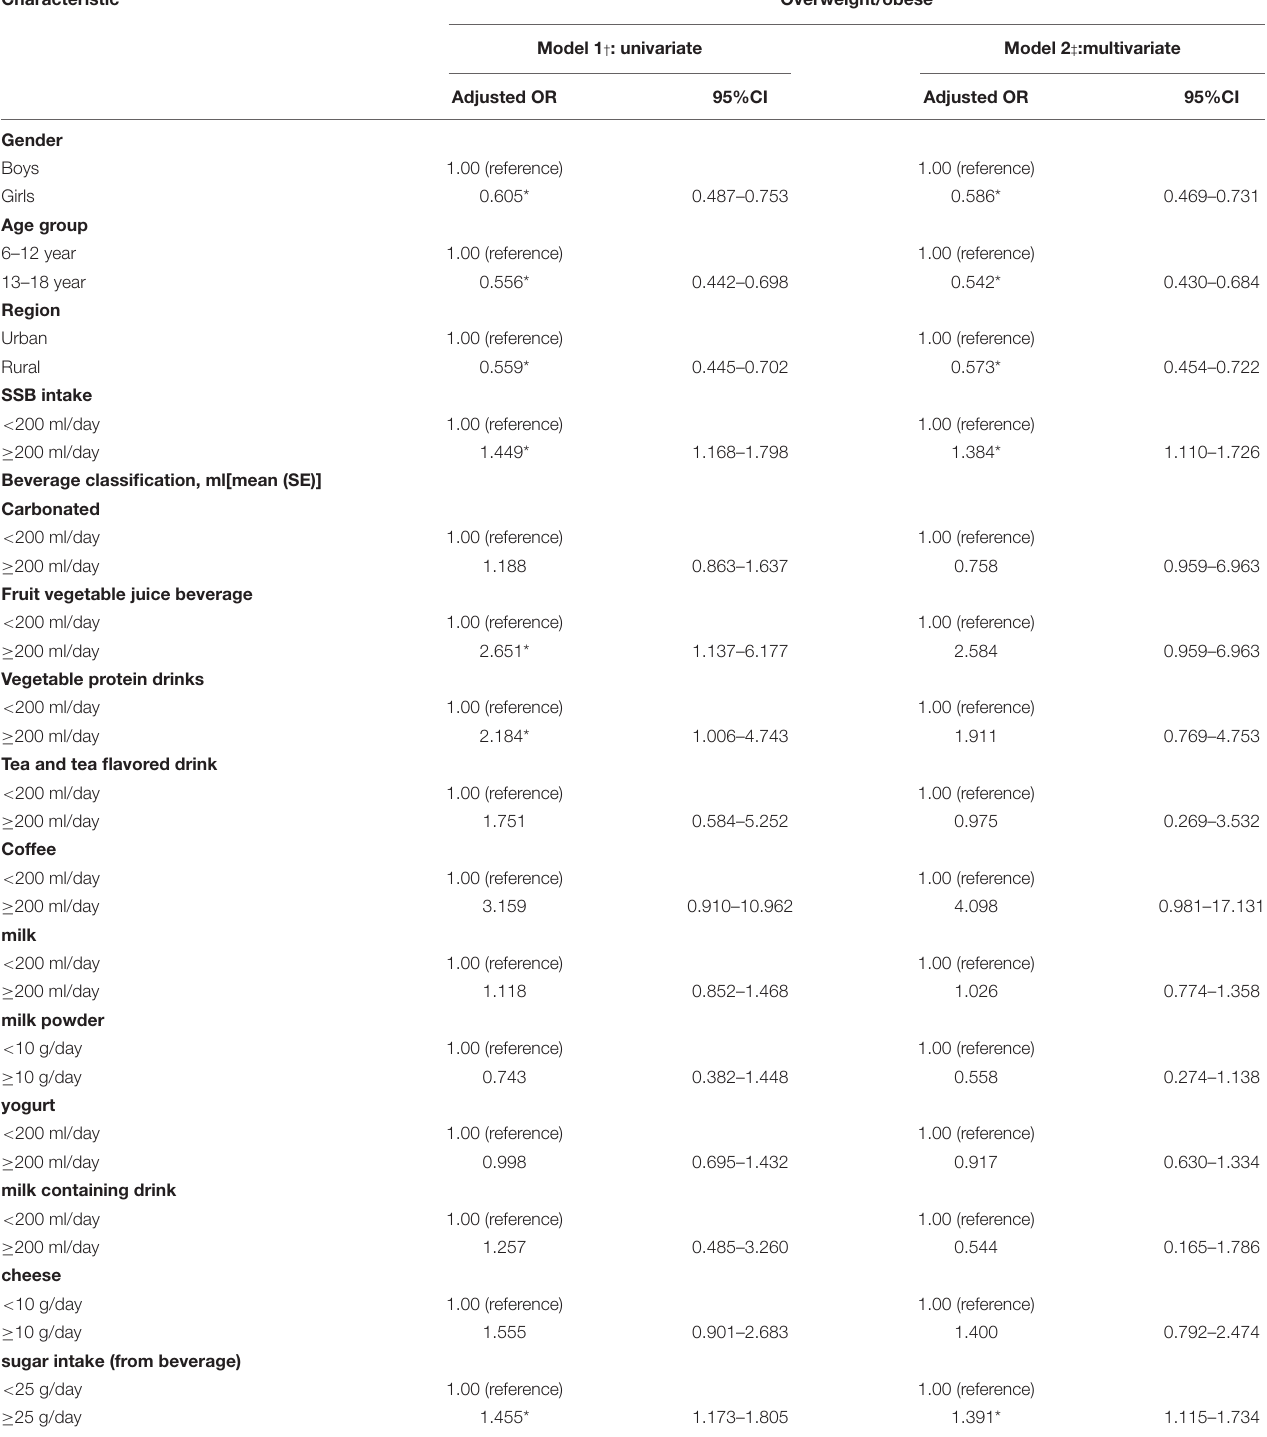
TABLE 3 | Adjusted odds ratios for variables associated with overweight/obese among 6–18 years in Shandong, China. Characteristic